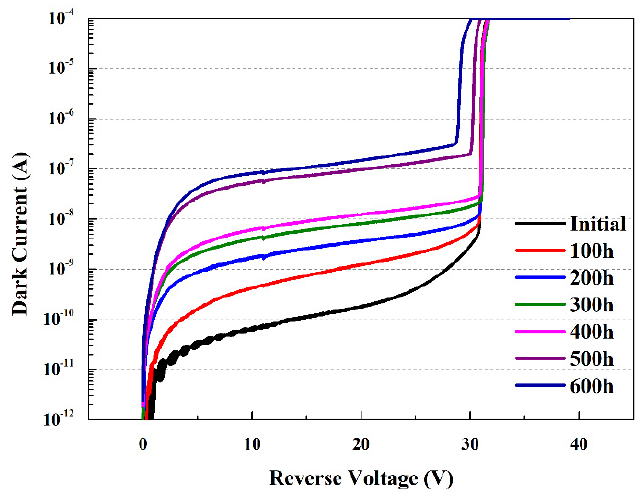
Figure 8. The typical current–voltage (I–V) characteristic degradation of the APDs at 473 K and 500 μ A.